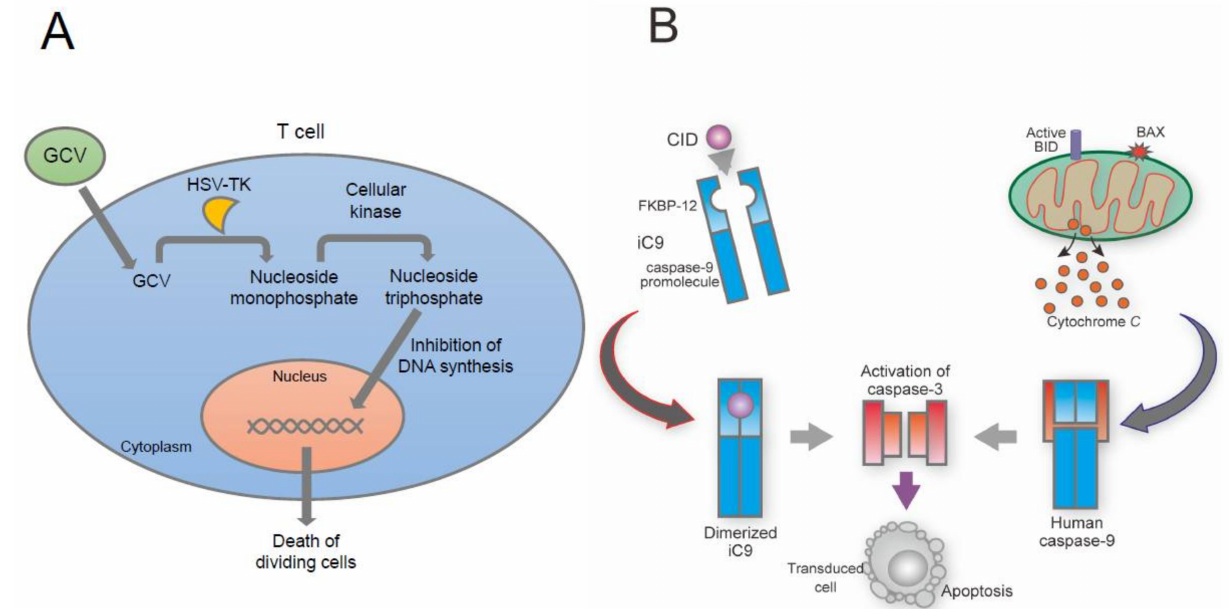
Figure 2. Expression of suicide genes in T lymphocytes. ( A ) HSV-TK phosphorylates ganciclovir (GCV) to nucleoside monophosphate, then a second cellular kinase phosphorylates this into nu- cleoside triphosphate. This inhibits DNA synthesis, resulting in death of dividing cells. ( B ) In the mitochondrial apoptosis pathway, translocation of activated BAX or BID to the mitochondria creates pores and allows cytochrome C to move to the cytosol. Cytochrome C then activates caspase-9, resulting in the activation of caspase-3, which leads to apoptosis. iC9 was made by the fusion of human caspase-9 to a modified FK506-binding protein (FKBP12), allowing dimerization. By adding CID, iC9 is dimerized and activates caspase-3 directly, also inducing